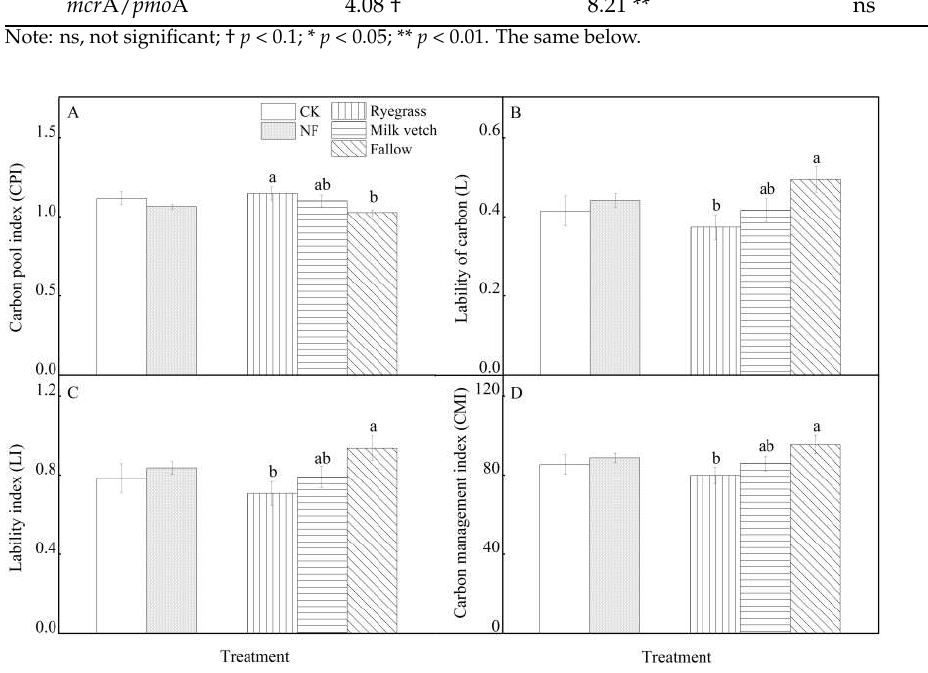
Table 3. F values for the effects and the interaction effects of green manure amendment (M) and fertilization (F) on soil carbon management indices and the copies of mcr A and pmo A genes. Soil Fertility Fertilization (F) Green Manure (M) M × F CPI ns 4.09 * ns L ns 4.20 * LI ns